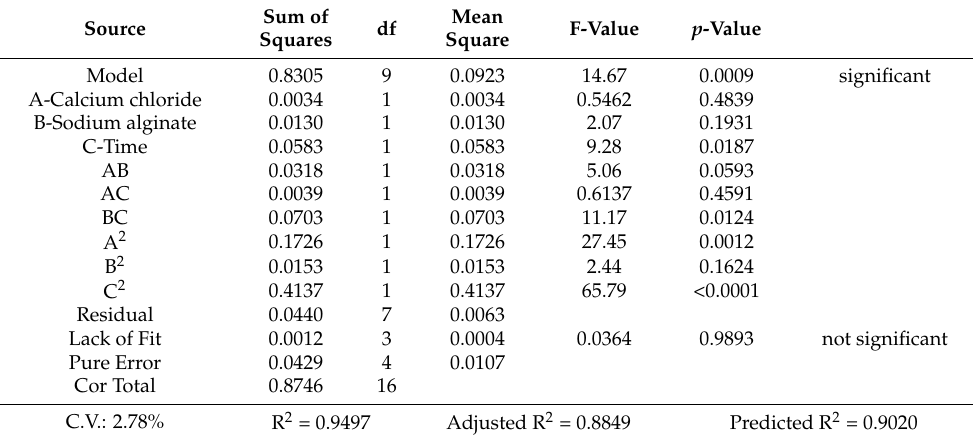
Table 4. ANOVA test for antioxidant activity.